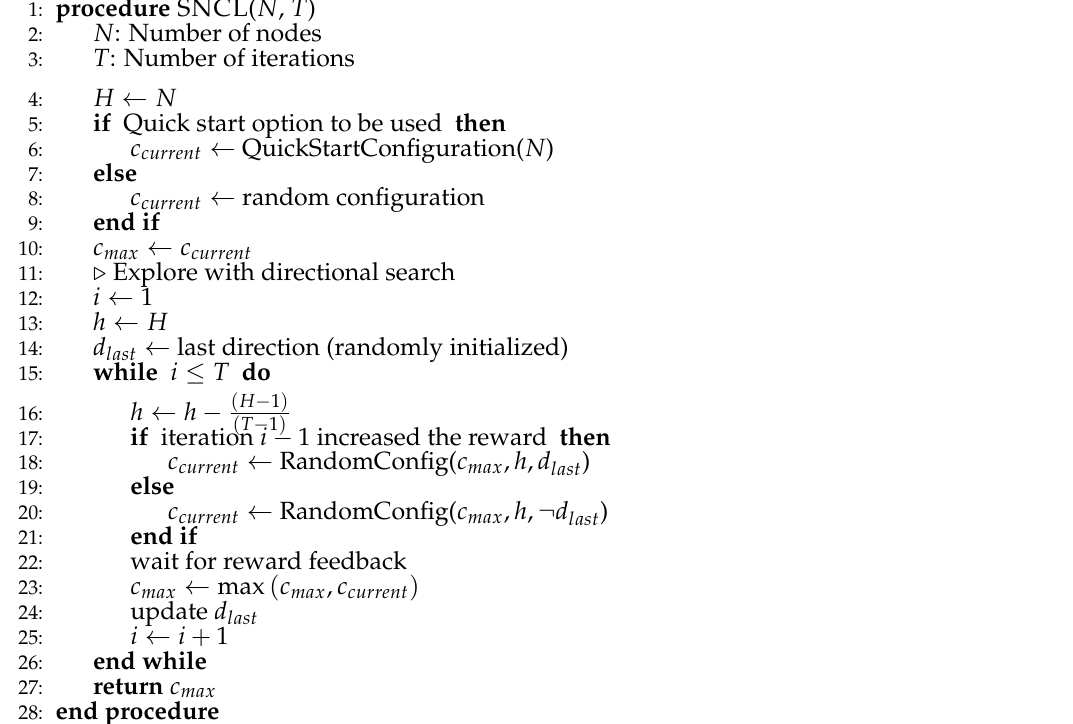
Algorithm 1 Sensor network configuration